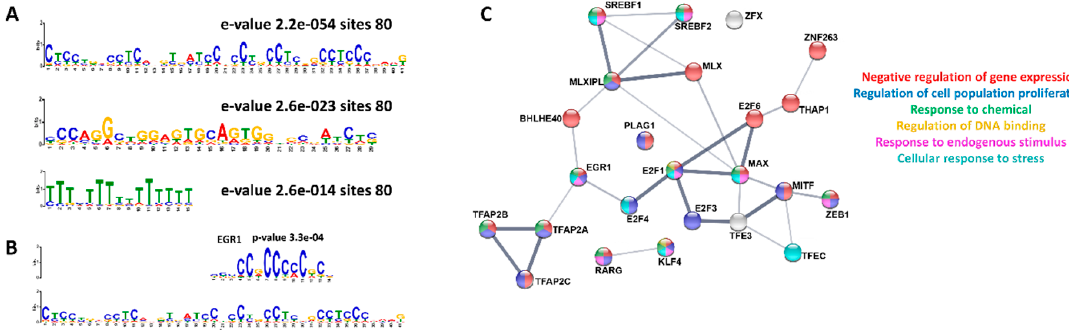
80 GeneHancer regions (FDR < 0.05) associated with the ASD curated genes in the CTD. ( B ) EGR1 is the top transcription factor that recognizes the top identified motif based on TomTom and JASPAR database search. ( C ) STRING plot of the transcription factors that recognize the top MEME motif. Colors correspond to the biological processes’ enriched terms based on gene ontology in the network. The biological processes found to be enriched include: negative regulation of gene expression (FDR 4.30 × 10 − 15 ), regulation of cell population proliferation (FDR 1.17 × 10 − 7 ), response to